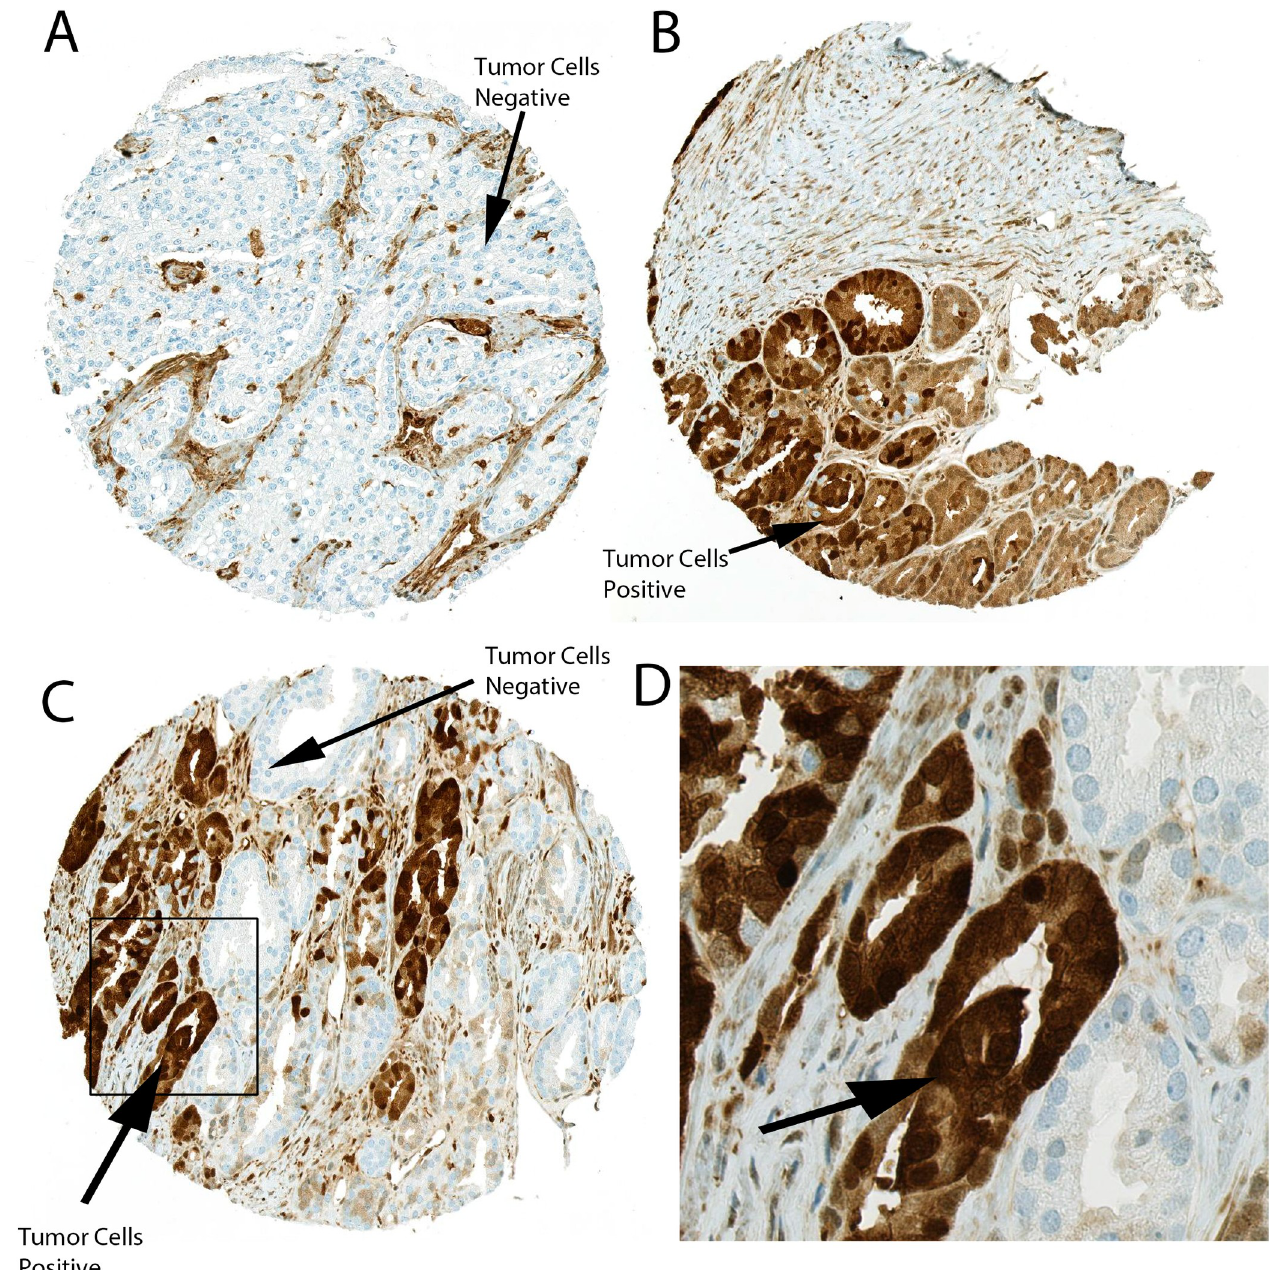
Fig 1. Patterns of GSTP1 protein staining. Medium power views of TMA spots containing adenocarcinoma with examples of all tumor cells being GSTP1-negative (A), all tumor cells being GSTP1-positive (B), and a spot with heterogeneous mosaic staining with some cells staining positively and some negatively (C). In all examples, there is abundant stromal cell staining that is most apparent in (A) in between tumor nests. Original magnification x 100. (D) Higher power view of boxed regions in (C).